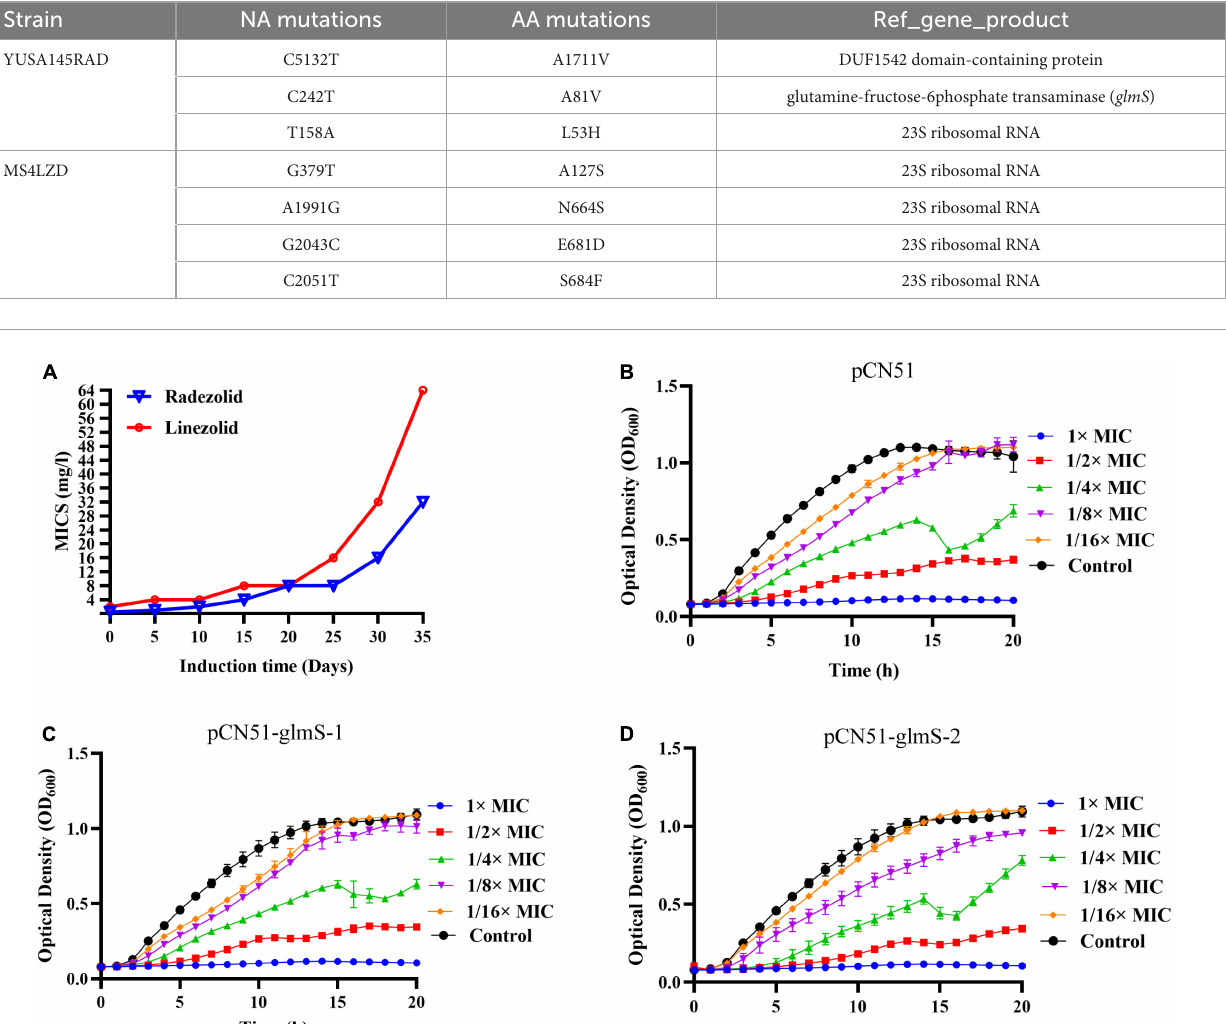
TABLE 3 Genetic mutations in YUSA145RAD and MS4LZD were detected by whole-genome sequencing. Strain